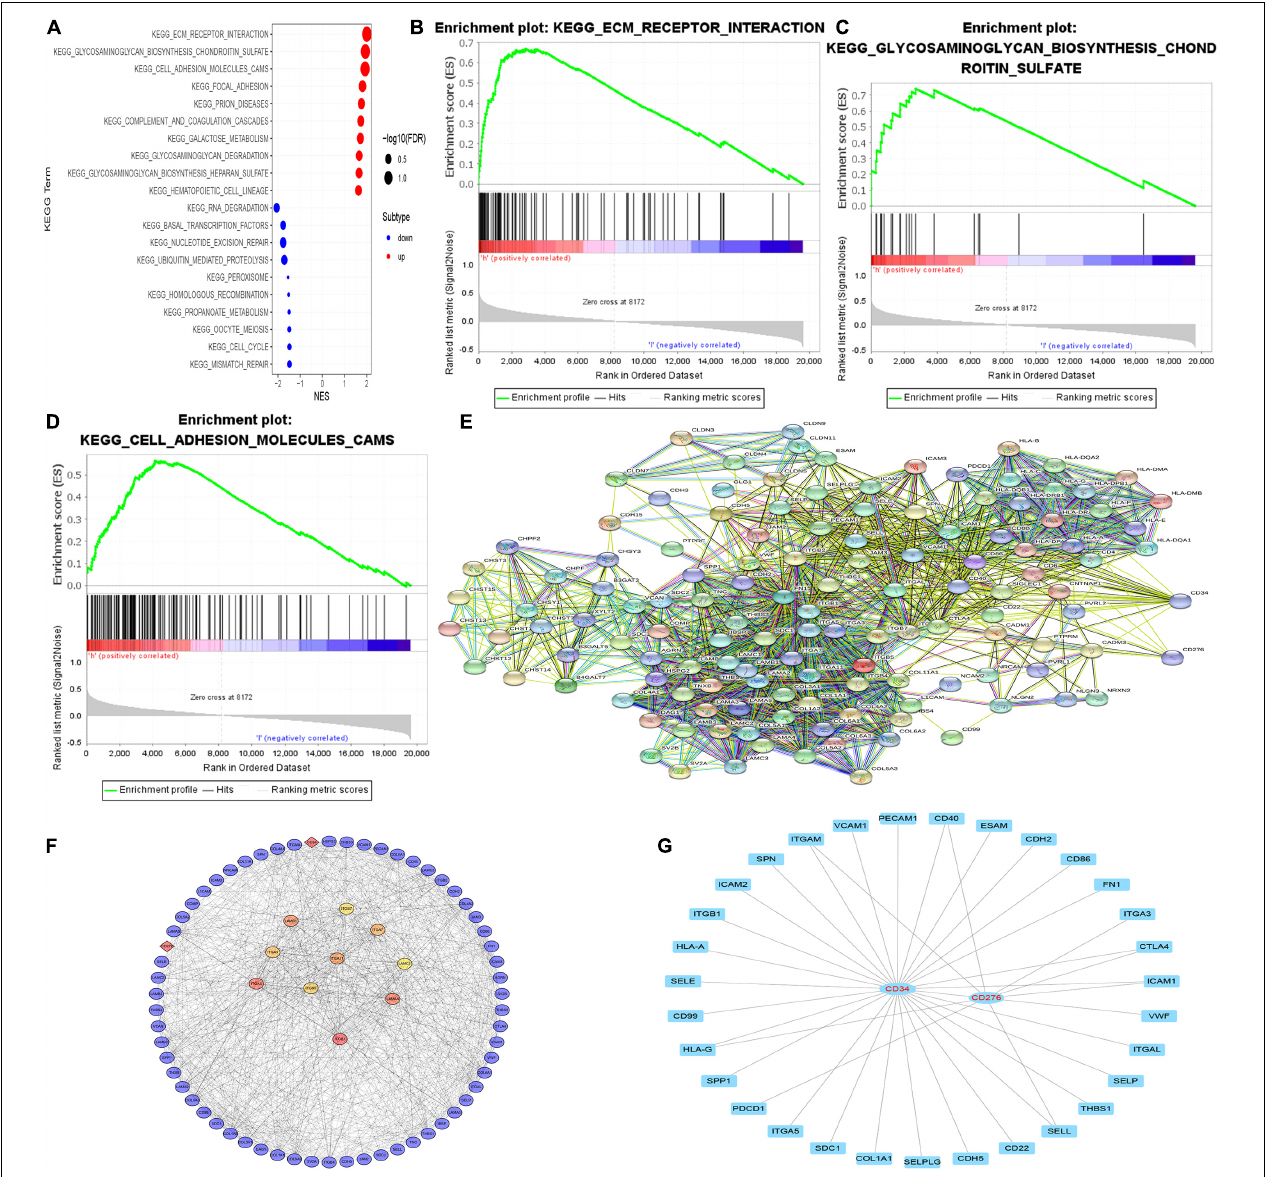
FIGURE 6 | GSEA enrichment analysis and PPI network. (A–D) According to both FDR and NES as screening conditions, ECM receptor interaction, glycosaminoglycan biosynthesis chondroitin sulfate, and Cell adhesion molecules (CAMS) are the best KEGG enrichment items. (E) The string online database was used to construct a PPI network for all genes in the optimally enriched KEGG signaling pathway (high confidence = 0.7). (F) MCC method was used to calculate the top 10 key proteins in the PPI network. (G) The molecule that acts directly with